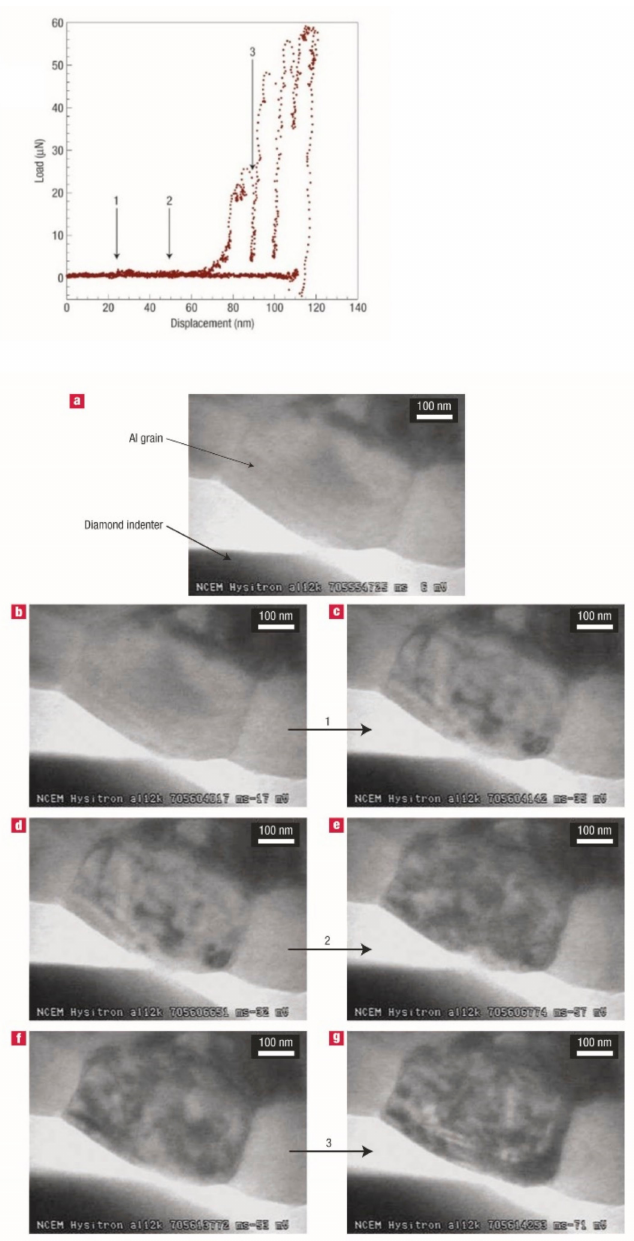
Figure 6. Load–displacement curve (above) and TEM micrographs (bottom) representing the mi- crostructural evolution sequence and the associated mechanical response during TEM in situ straining of Al [42]. The indented grain is initially free of dislocations ( a ), ( b , c ), ( d , e ), and ( f , g ), extracted video frames corresponding to transients arrowed as 1, 2, and 3 in the above load-displacement